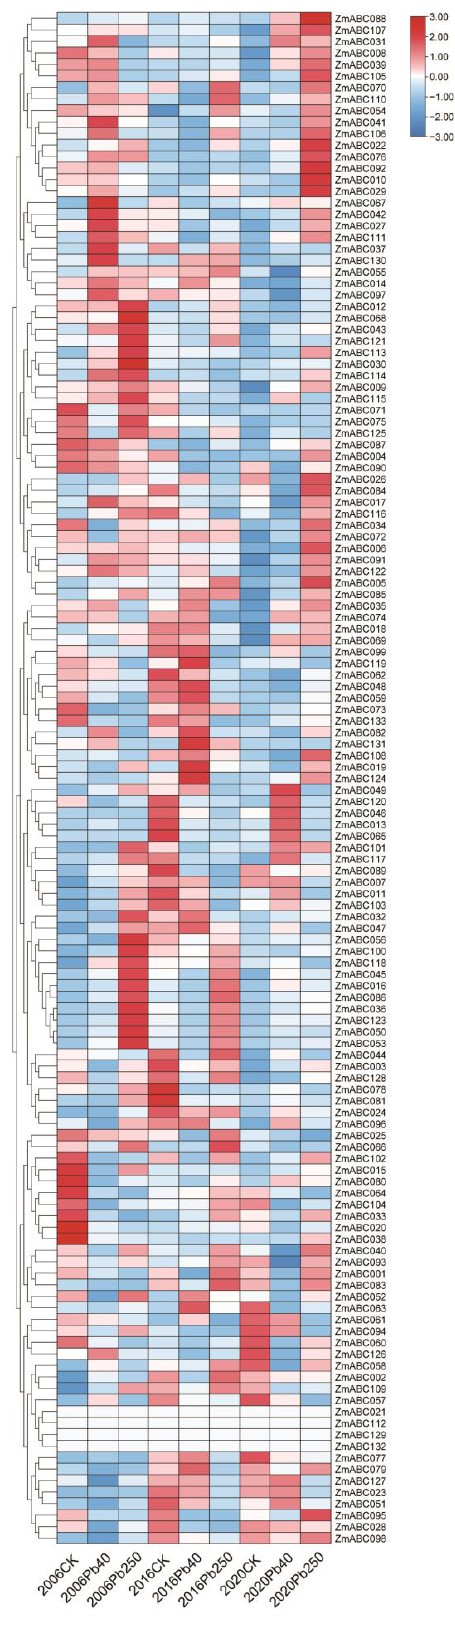
Figure 5. Expression analysis of ZmABC genes of maize cultivar B after treatment with Pb.